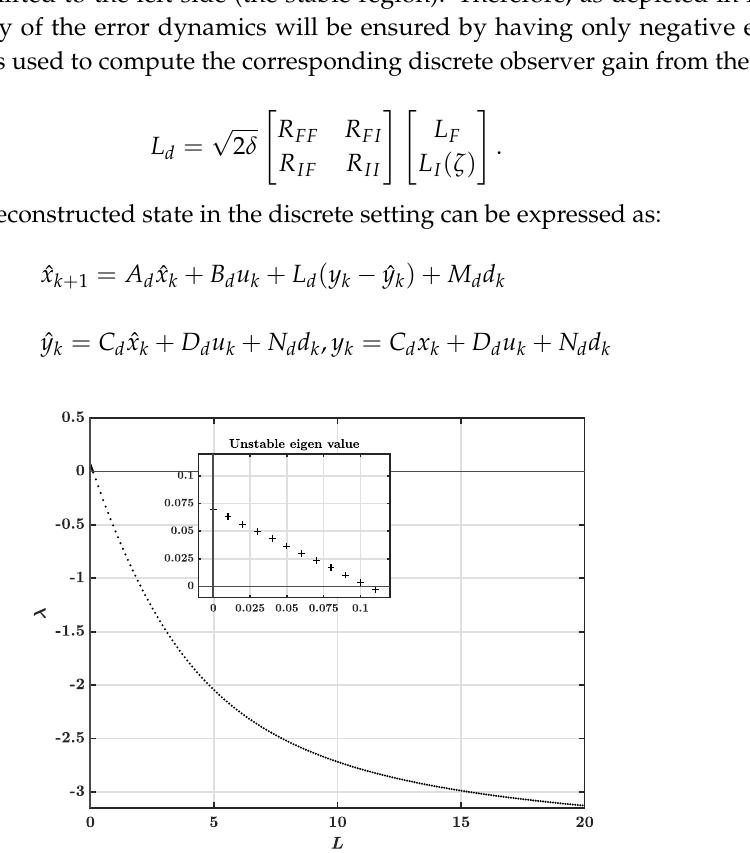
Figure 4. Shifting the unstable eigenvalue of the observer for different values of the observer